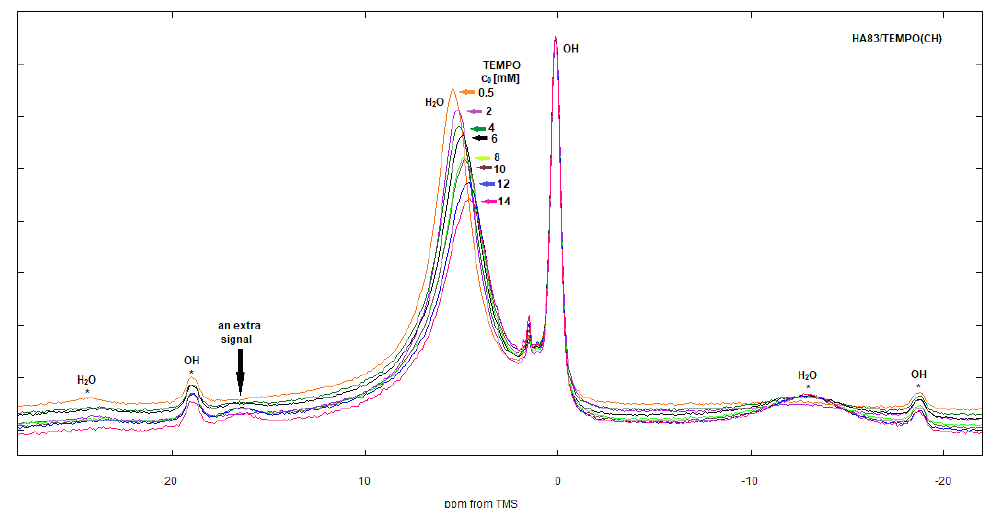
Figure 8. 1 H NMR spectra of the HA83/TEMPO(CH) composites, shown for different TEMPO concentrations c 0 applied during adsorption. The spectra were normalized to the same sample mass and scaled to the same intensity of the 0 ppm peak. Asterisks denote spinning sidebands.